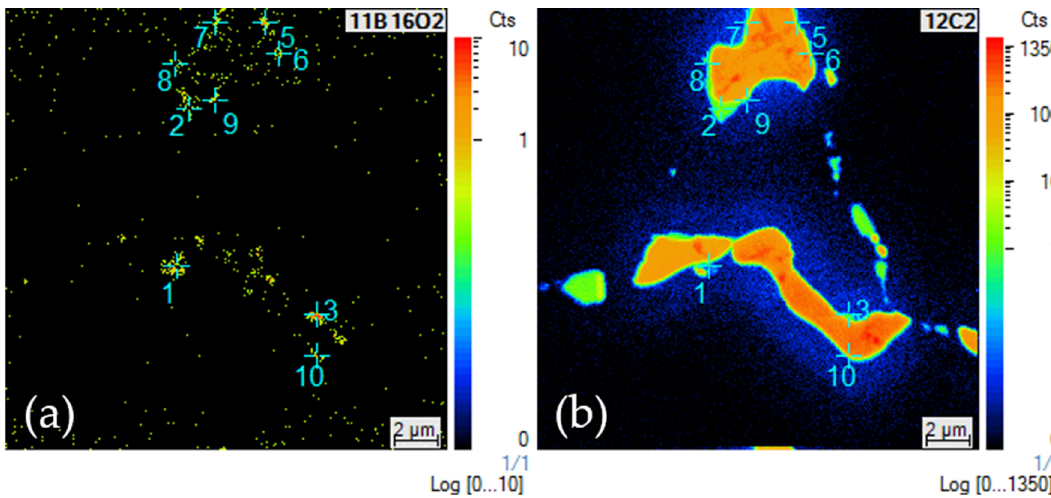
Figure 13. Elemental map showing ( a ) B segregation at interface of ( b ) Ti–Mo (MC) carbides at 1160 °C. At 1190 C, B was found to be present in free form at the grain boundaries (Figure 14). This temperature was high enough to dissolve the B-rich particles. Line scans clearly revealed that B was segregated at the grain